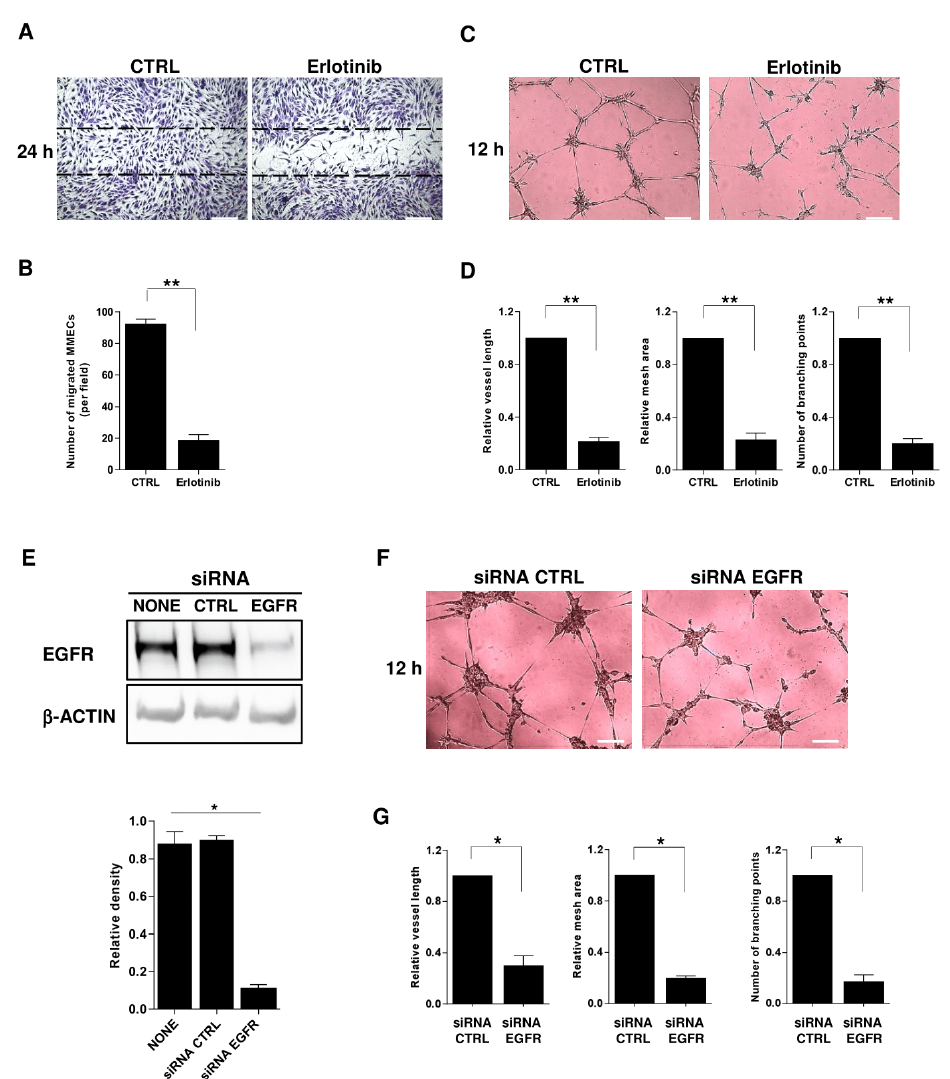
Figure 5. Erlotinib restrains the in vitro angiogenic potential of MMEC. ( A , B ) Wound-healing assay. ( A ) Photomicrographs of MMEC in serum-free medium without (CTRL) or with 10 µ M erlotinib, 24 h after wounding. ( B ) Counts of migrating cells in each wound of (A). ( C , D ) Angiogenesis assay. ( C ) Photomicrographs of MMEC, 12 h after seeding on Matrigel without (CTRL) or with 10 µ M erlotinib. ( D ) Quantification of angiogenic behavior in ( E ) by topological analysis. ( E ) Western blot of MMEC transfected with no nucleotides (CTRL), 50 nM control, non-targeting siRNA, or 50 nM EGFR siRNA for 48 h, and densitometric analysis of EGFR normalized to β -actin. ( F ) Photomicrographs of MMEC transfected with EGFR siRNA or control non-targeting siRNA seeded on Matrigel for 12 h. Images are representative of six experiments. ( G ) Quantification of angiogenic behavior in ( F ) by topological analysis. Data are mean and SD of six independent experiments. * p < 0.05 and ** p < 0.01, Mann–Whitney U test.